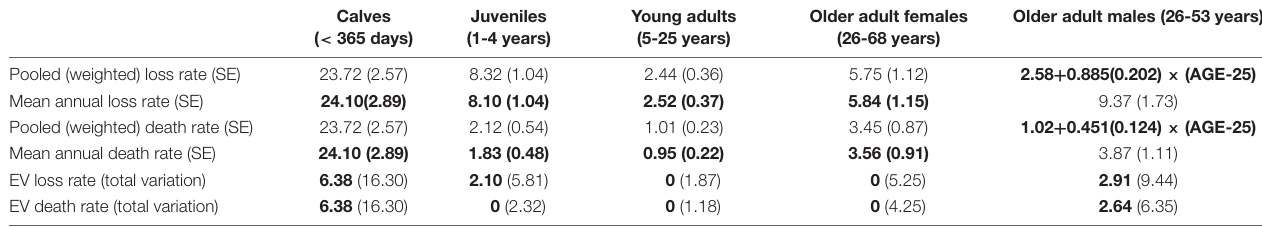
TABLE 3 | Calculated rates of disappearance (“Loss”) and documented deaths with SE in parentheses, and environmental variation in the rates given as SD, with total observed annual variation (EV plus sampling variance) expressed as an SD in